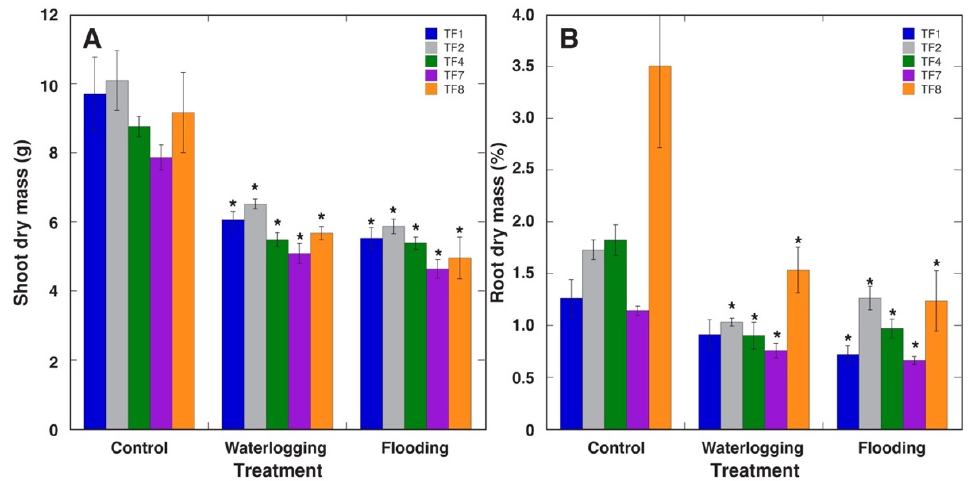
Figure 3. Effect of increased soil moisture in the form of waterlogging and flooding on shoot dry mass ( A ) and root dry mass ( B ) of Trifolium fragiferum plants of different accessions. Measurements were performed after three weeks of treatment plus four weeks of recovery. Data are means ± SE from five plants. Asterisks indicate statistically significant difference ( p < 0.05) from control for the respective accession.